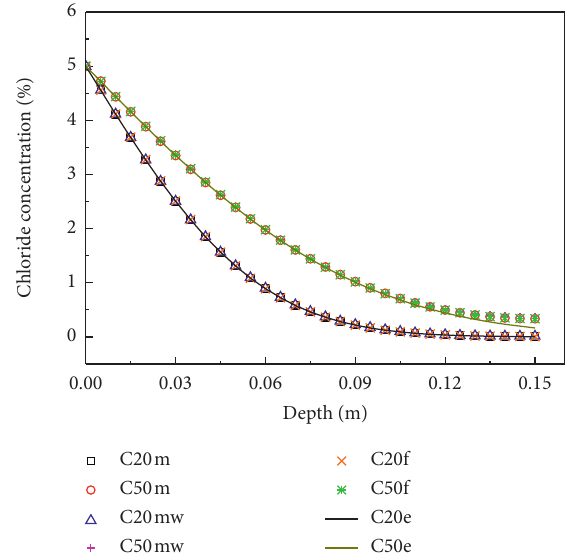
Figure 1: Change in chloride concentration with depth.